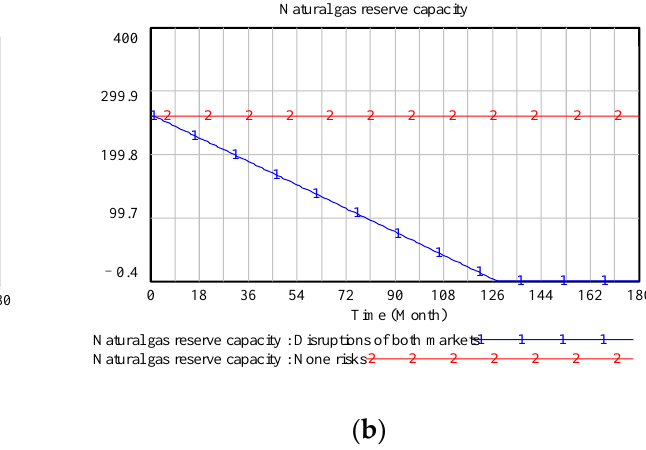
Figure 3. Authenticity test results: ( a ) the behavior of the coupled markets’ satisfaction rate under two extreme scenarios; ( b ) the behavior of natural gas reserves under two extreme scenarios.